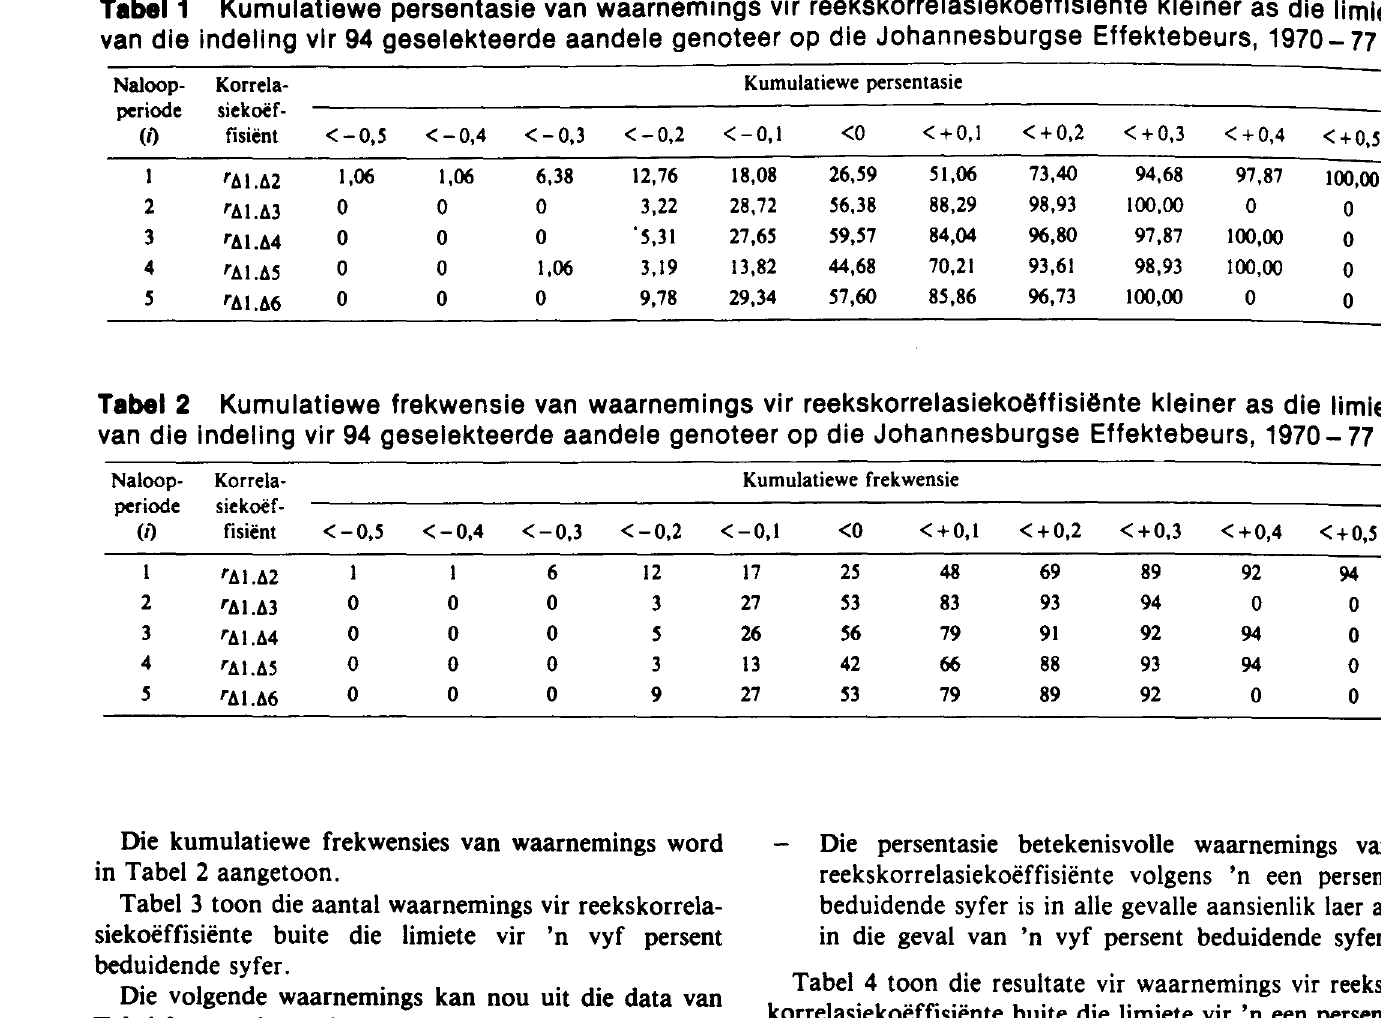
Die aantal waarnemings wat betekenisvolle